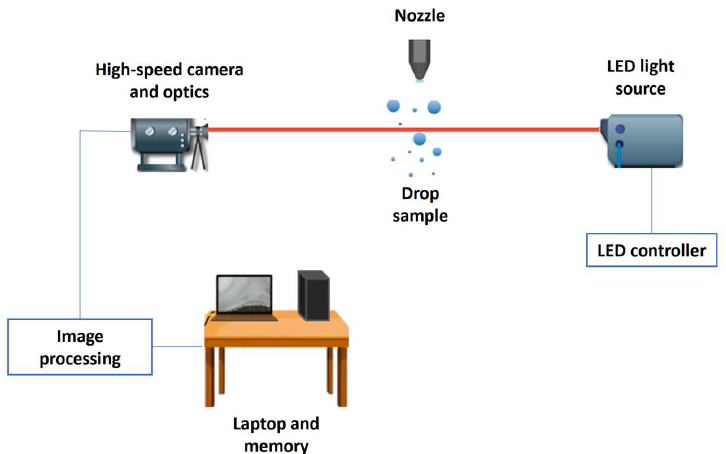
Figure 4. Scheme of HSI measurement system.